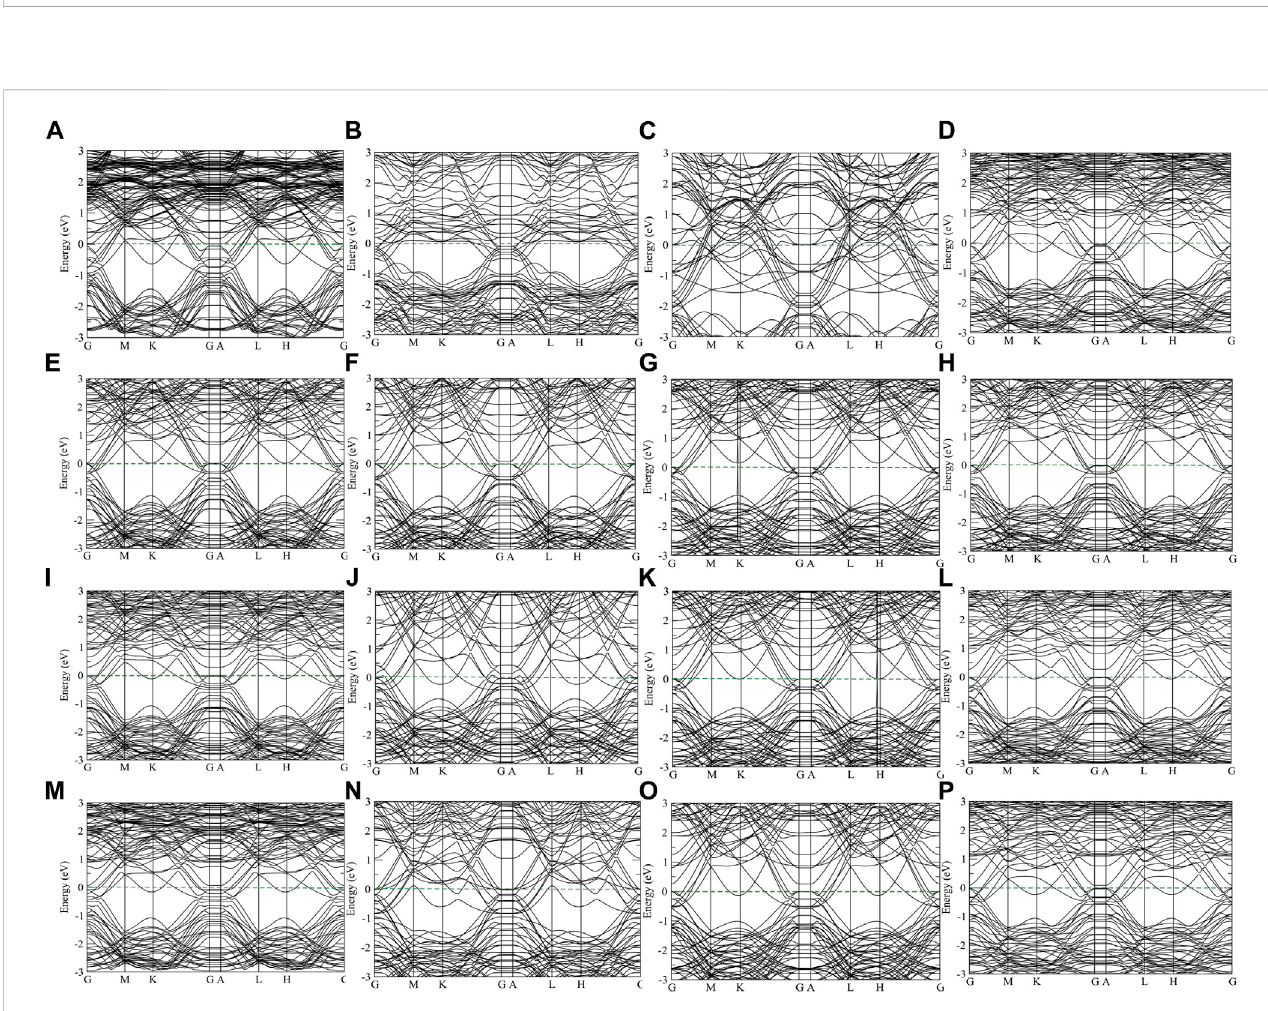
The electronic band structures of clean (A) CrN, (B) NbN, (C) ZrN and (D) VN, one layer of (E) CrN, (F) NbN, (G) ZrN, and (H) VN, two overlayers of (I) CrN, (J) NbN, (K) ZrN, and (L) VN, three overlayers of (M) CrN, (N) NbN, (O) ZrN, and (P) VN on TiN, respectively. The Fermi energy is set as zero energy point.